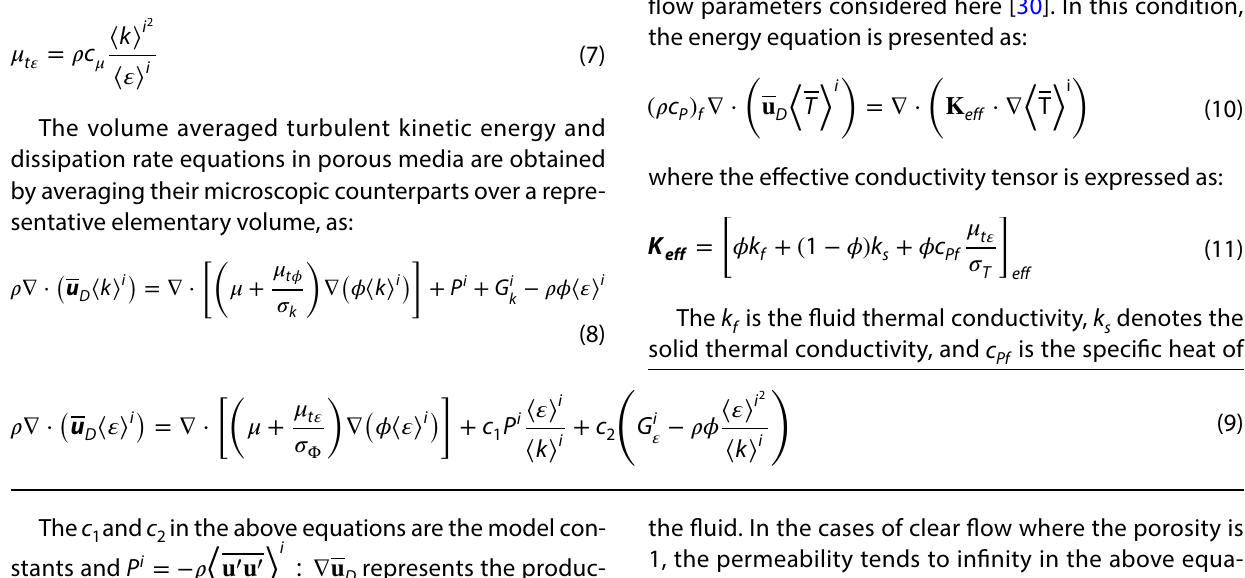
Table 1 The k ∞ and 𝜀 ∞ expressions in the modified k – ε model